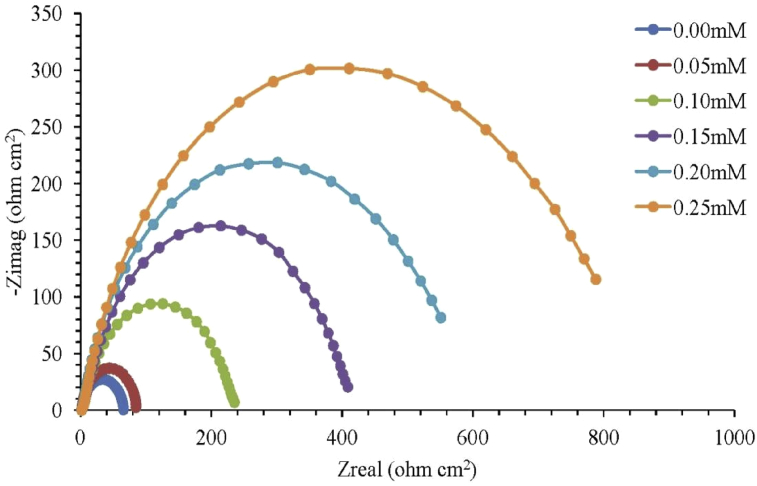
Mild steel Nyquist plot in 1M H2SO4 at 30 °C for varying OGCI concentrations [86].